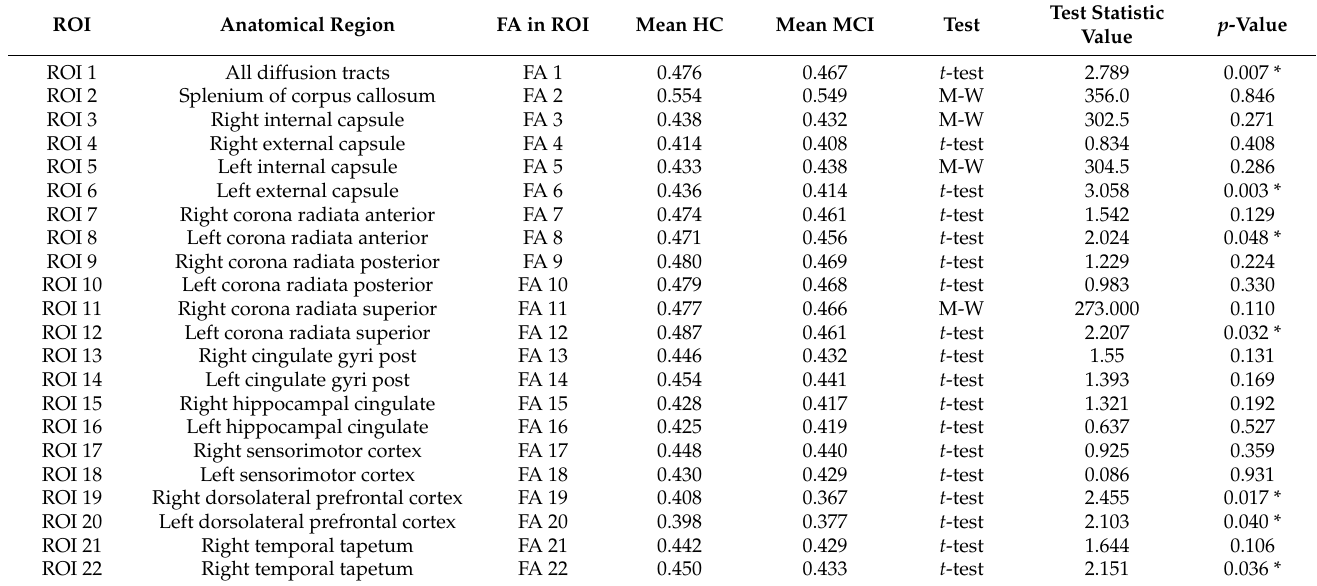
Table 2. Group differences in fractional anisotropy (FA) values in different regions of interest (ROIs) obtained for older healthy controls (HC) and older adults with mild cognitive impairment (MCI).